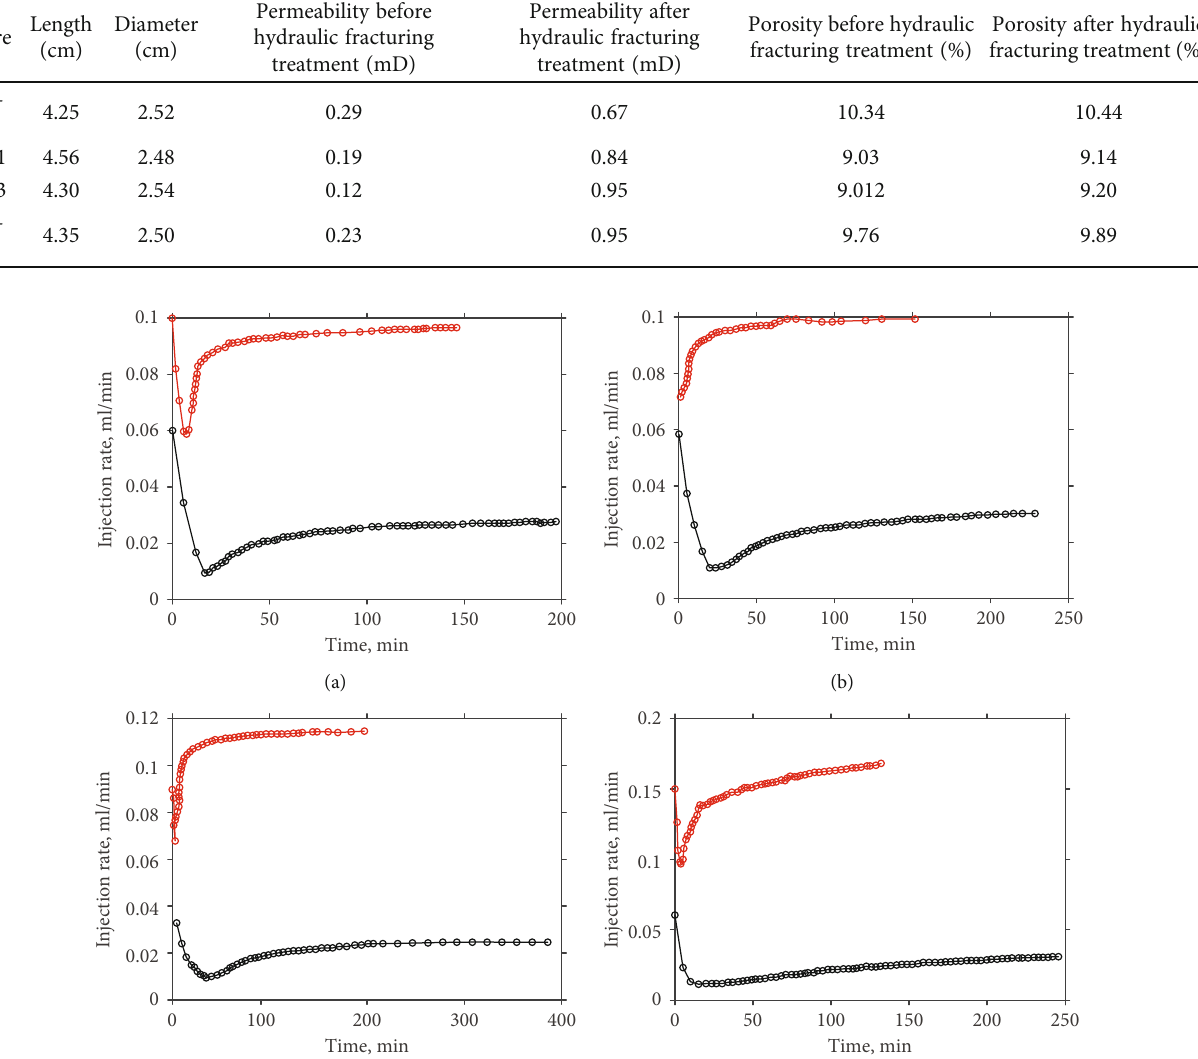
Table 1: Parameters of samples used in water fl ooding tests.